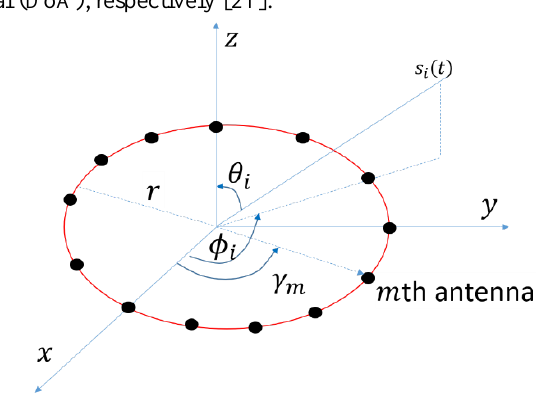
Fig. 3. Illustration of uniform circular array (UCA) Where 𝑟 and 𝑀 are radius and total number of elements, respectively. The elements are assumed to be identical and omnidirectional. The elevation and azimuth angles of impinging signal denoted by 𝜃 ∈ [0, 𝜋 ⁄2] and 𝜙 ∈ [0, 2 𝜋 ]. The angle between the 𝑚 th element of array and the 𝑥 -axis, for 𝑚 𝜖 [0, 𝑀 − 1] is 𝛾 = 2𝜋(𝑚 𝑀⁄ ), 𝑚 = 1,2, … … , 𝑀 , 𝑚 = 𝑚 1,2, … … , 𝑀 . The phase difference (of the complex envelope of the field at 𝑚 th element with respect to the origin) is 𝛥𝜙 ) . 𝑘 = 2𝜋/𝜆 , is the wave number, 𝑘𝑟 sin 𝜃 cos ( 𝜙 − 𝛾 𝑖 𝑖 𝑚